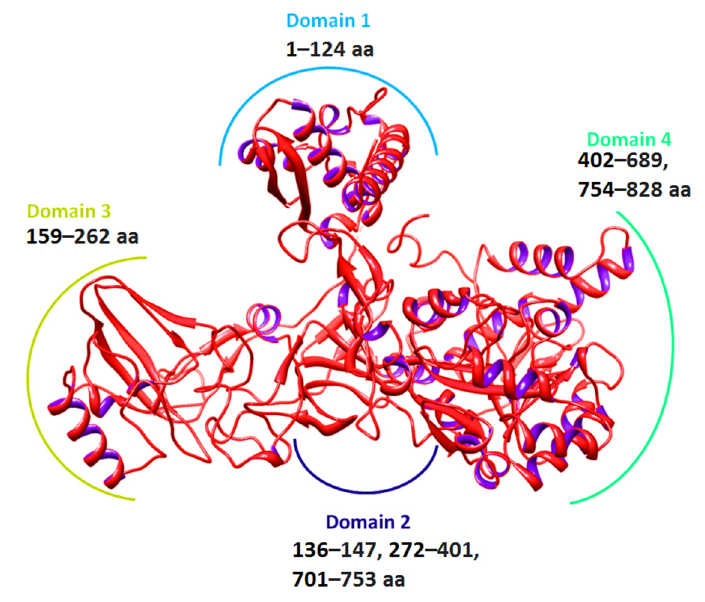
Figure 4. Crystalline structure of jack bean urease [JBU] [4H9M].